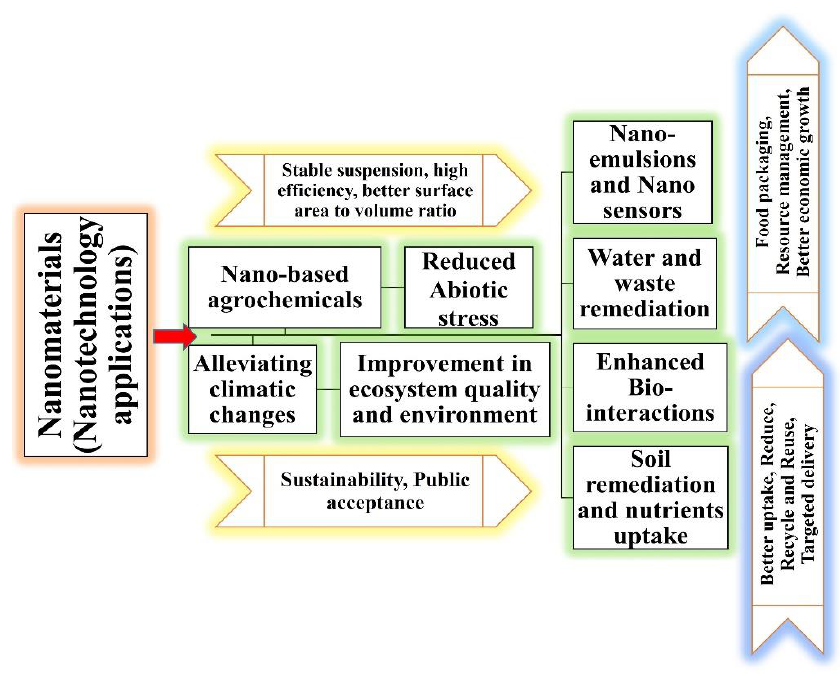
Figure 1. Application of nanomaterials in ecosystem and agricultural sustainability.